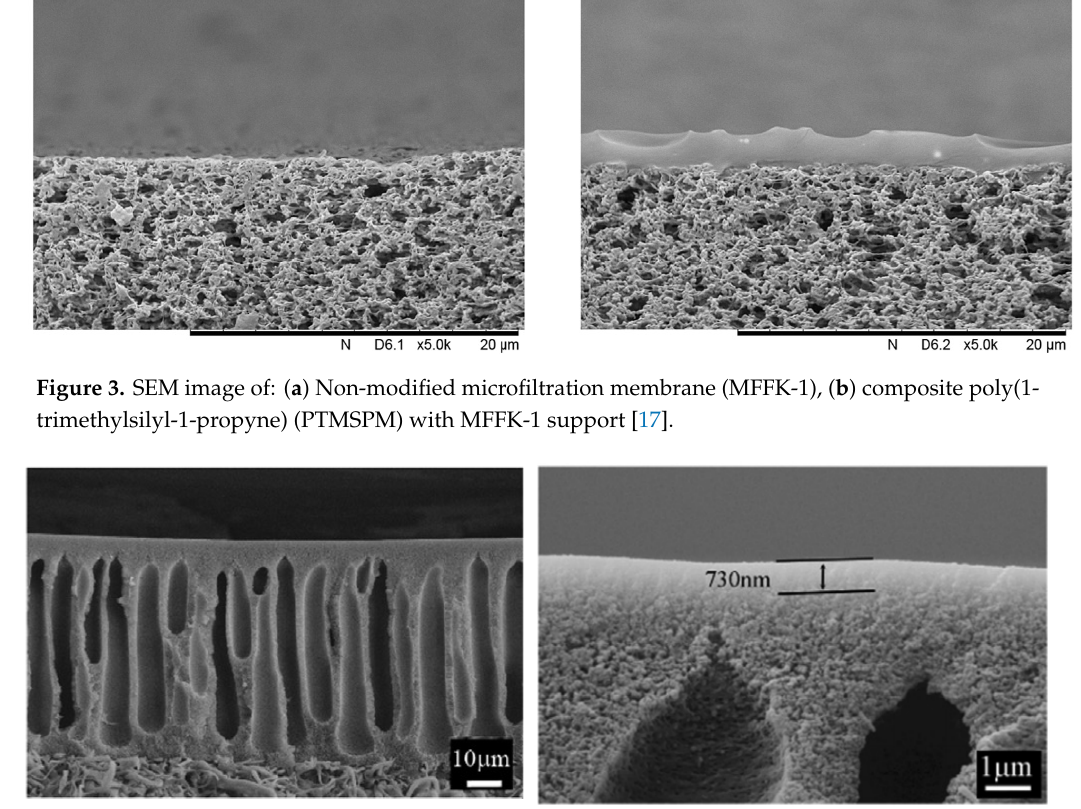
Figure 4. SEM image of the cross ‐ section polyetherimide membrane showing porous and dense structures ( left ) and measurement of the dense layer ( right )[19].